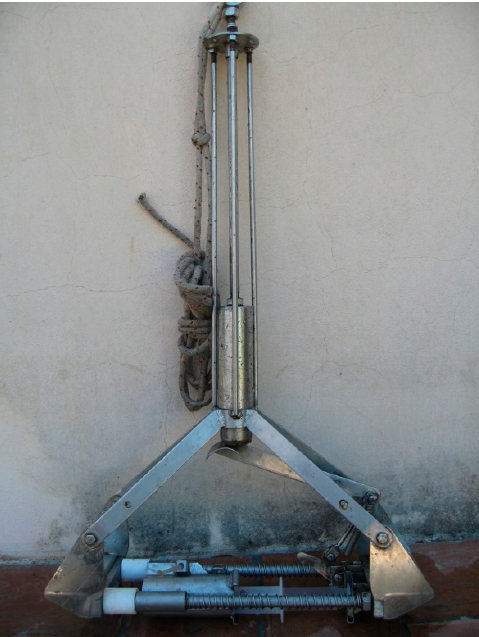
Figure 5. Horizontal coring instrument for collecting 60 mL of surface sediment (3–4 cm thick). After positioning the instrument’s base on the bottom, sending the messenger (vertically arranged metal block) triggers the spring that drags the syringe along the horizontal path at the instrument’s base, collecting the sediment material.